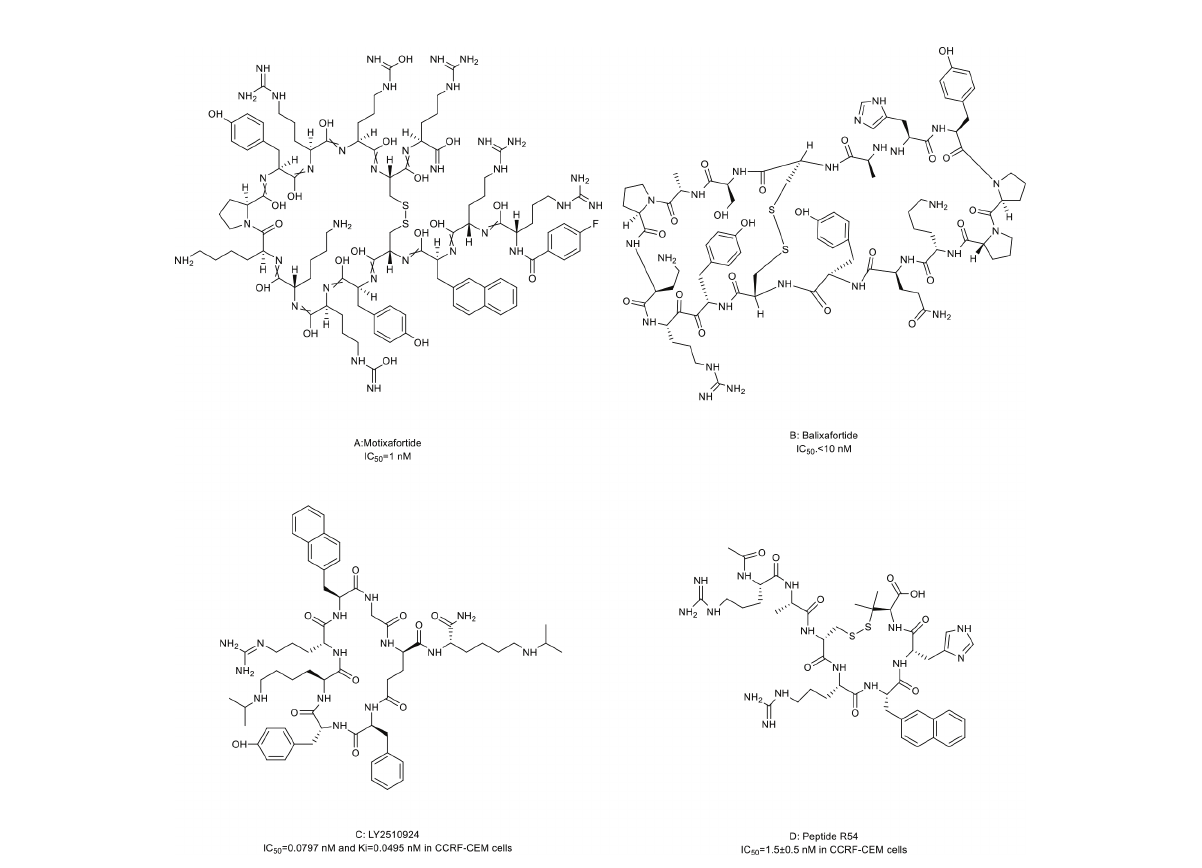
FIGURE 3 Macrocyclic peptides targeting CXC chemokine receptor 4 (CXCR4). (A) Motixafortide, IC50: 1 nM; (B) Balixafortide, IC50: 10 nM; (C) LY2510924, IC50: 0.0797 nM in CCRF-CEM cells; (D) Peptide R54, IC50: 1.5 nM in CCRF-CEM